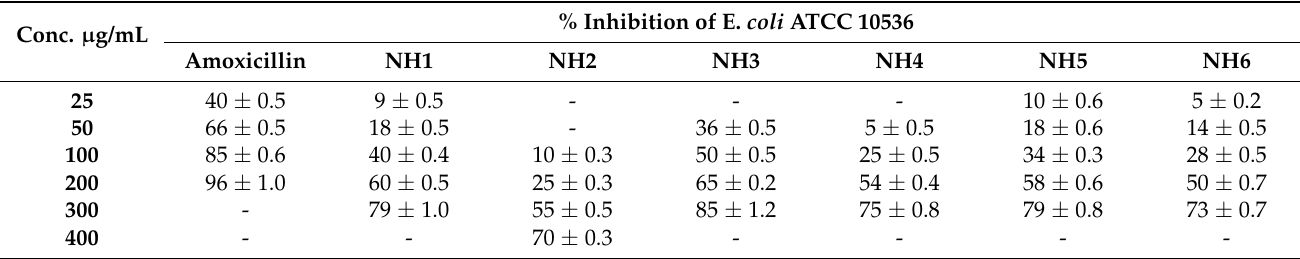
Table 5. Minimum inhibitory concentration of synthesized compounds against Escherichia Coli .